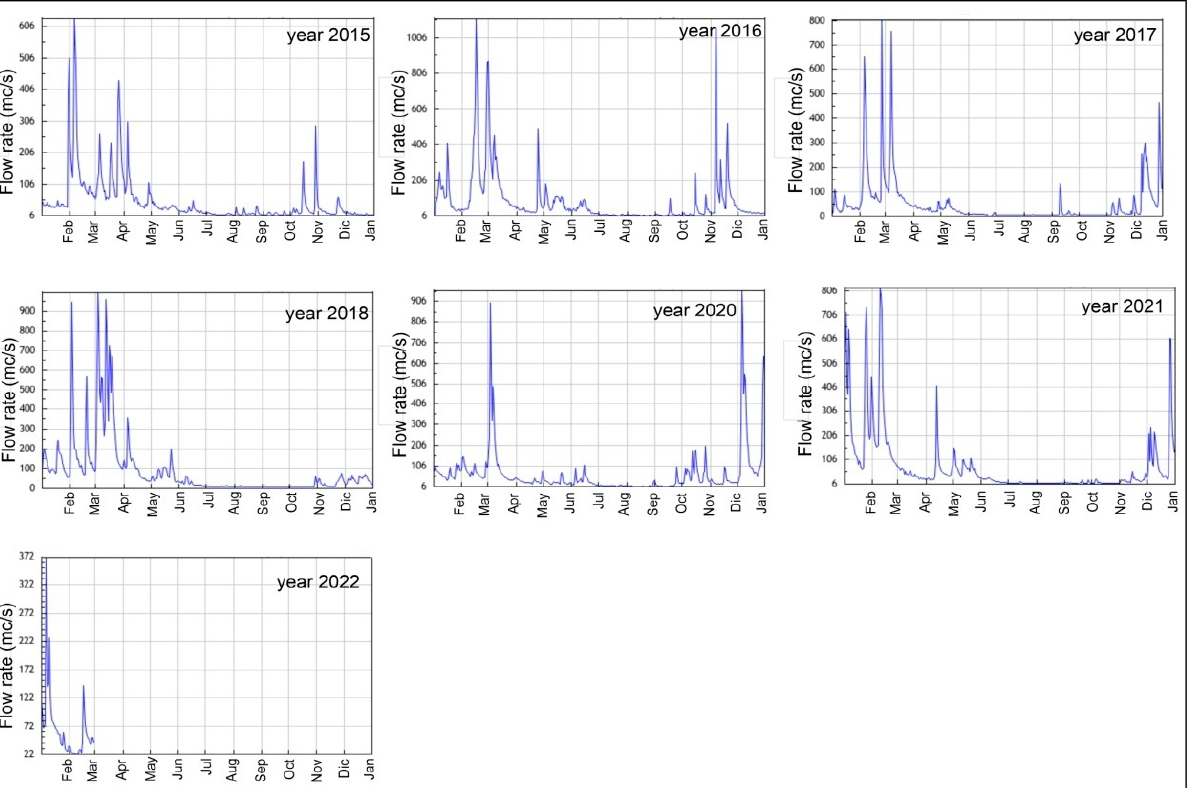
Figure 9. Flow rate of the Arno River between the years 2015 and 2022.